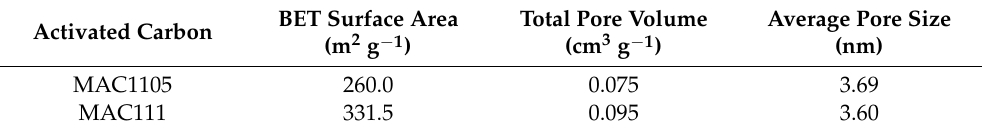
Table 1. Textural characteristics of the magnetic activated